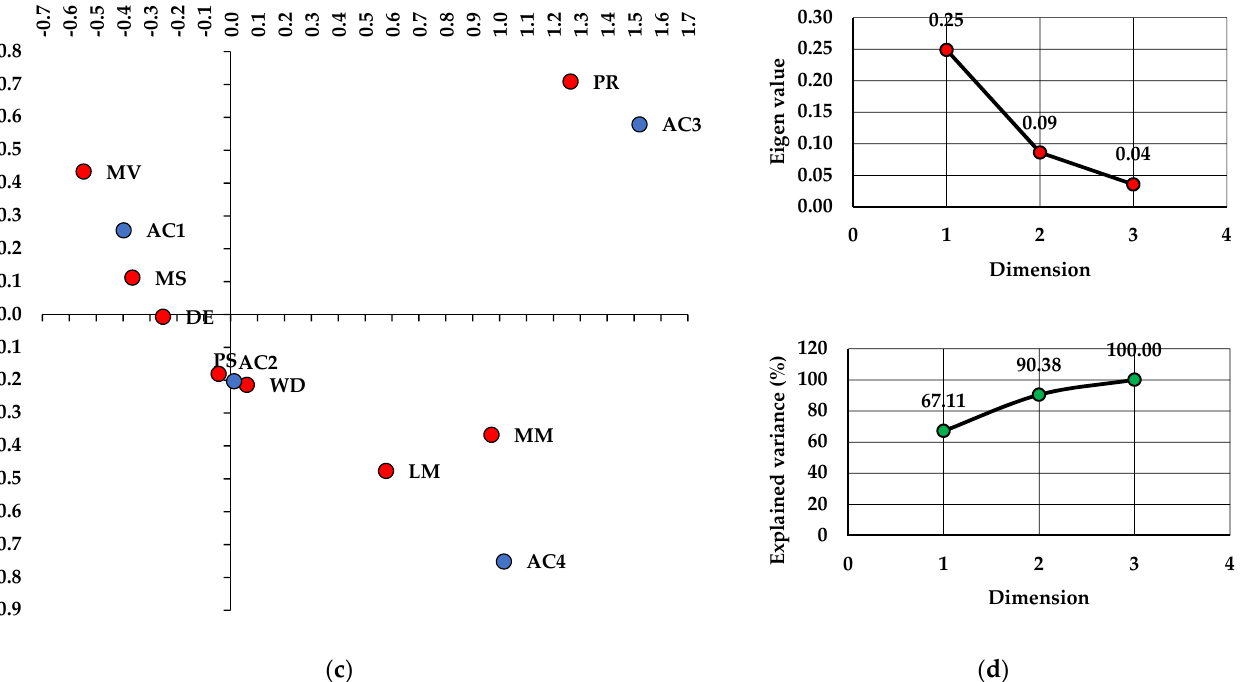
Figure 3. Results of the correspondence analysis showing the trends in data dependencies: ( a ) biplot of body postures and tasks; ( b ) eigen values and the proportion of explained variance as a function of the number of dimensions characterizing the data from ( a ); ( c ) biplot of action categories and tasks; ( d ) eigen values and the proportion of explained variance as a function of the number of dimensions characterizing the data from ( c ). Legend: B1—back straight; B2—back bent forward or backward; B3—back twisted or bent sideways; B4—back bent and twisted or back bent forward and sideways; A1—both arms below shoulder level; A2—one arm is at or above the shoulder level; A3—both arms are at or above the shoulder level; L1—sitting; L2—standing with both legs straight; L3—standing with the weight on one straight leg; L4—standing or squatting with both knees bent; L5—standing or squatting with one knee bent; L6—kneeling on one or both knees; L7—walking or moving; MS—scanning by the mobile laser scanner; LM—marking the logs by paint; MM—measuring manually the diameters; MV—moving; DE—delays; PS—scanning by the smartphone; PR—preparing the tasks; WD—writing data on a field book; AC1—first action category, no corrective actions needed; AC2—second action category, corrective actions needed in the near future; AC3—third action category, corrective actions needed as soon as possible; and AC4—fourth action category, cor-